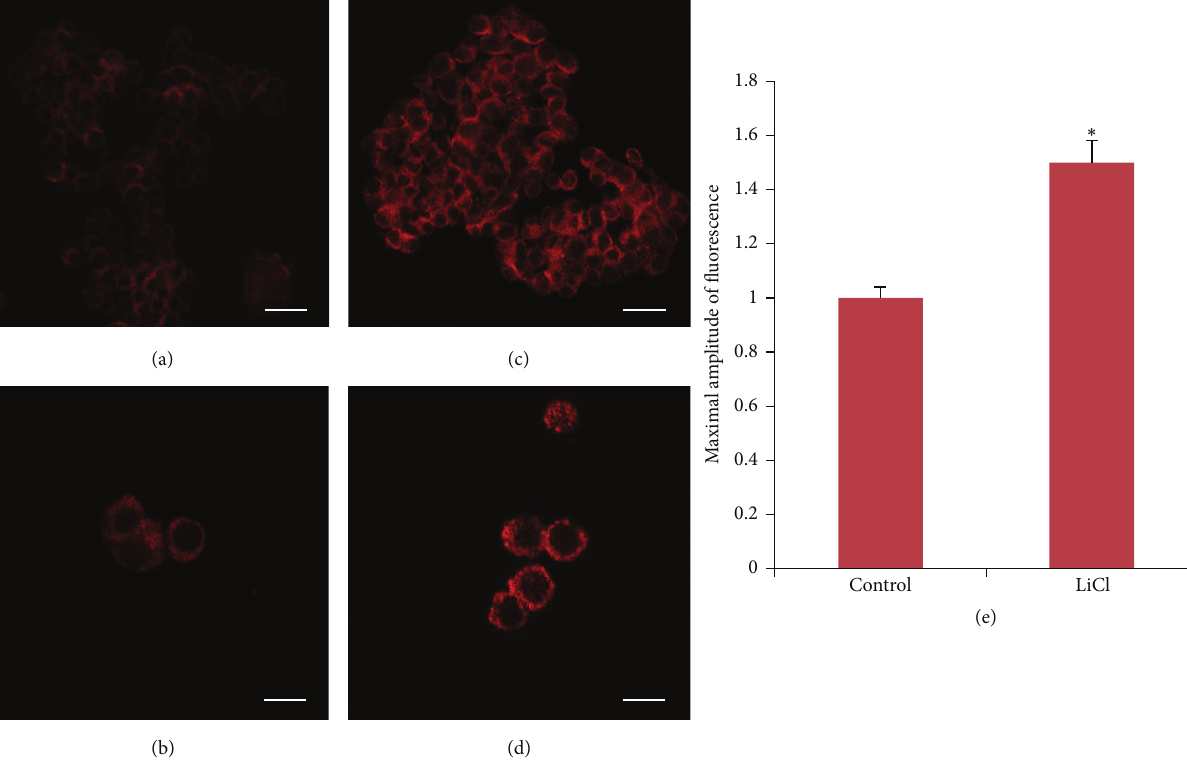
Figure 4: Confocal microscopy of LC3B distribution in PC12 cells after treatment for 24 hours with 0.5 mM lithium. Left panel: representative image of control ((a), (b)) and lithium-treated samples ((c), (d)). Scale bars = 20 𝜇 m ((a), (c)); 40 𝜇 m ((b), (d)). (e): quantitative analysis. The data represent the mean ± SE of maximal amplitude of fluorescence. ∗ 𝑃 < 0.001 versus